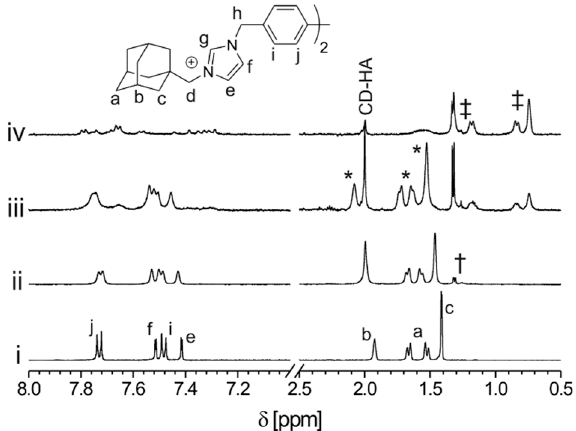
Figure 4. Stacking plot of portions of the 1 H-NMR spectra recorded within the competitive experiment in D 2 O at 30 °C. Free guest G2 ( i ); G2 and 1 eq. of CD-HA ( ii ); G2 , 1 eq. of CD-HA and 1 eq. of CB7 ( iii ); G2 , 1 eq. of CD-HA and 2 eq. of CB7 ( iv ). The signal of the residual propan-2-ol is marked with † and signals of the adamantane cage complexed with β -CD and CB7 macrocycle are marked with * and ‡, respectively.